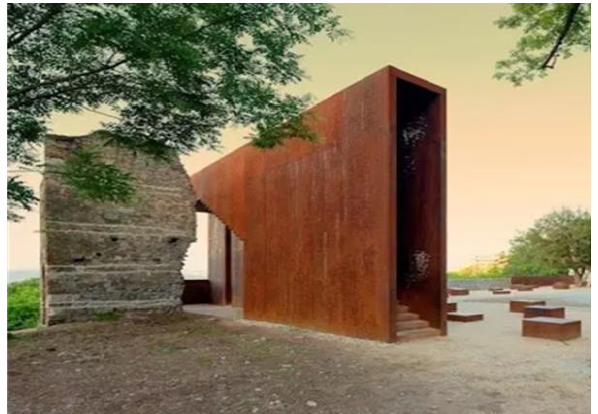
Figure 28. Vernacular landscape structures (source: [54]).